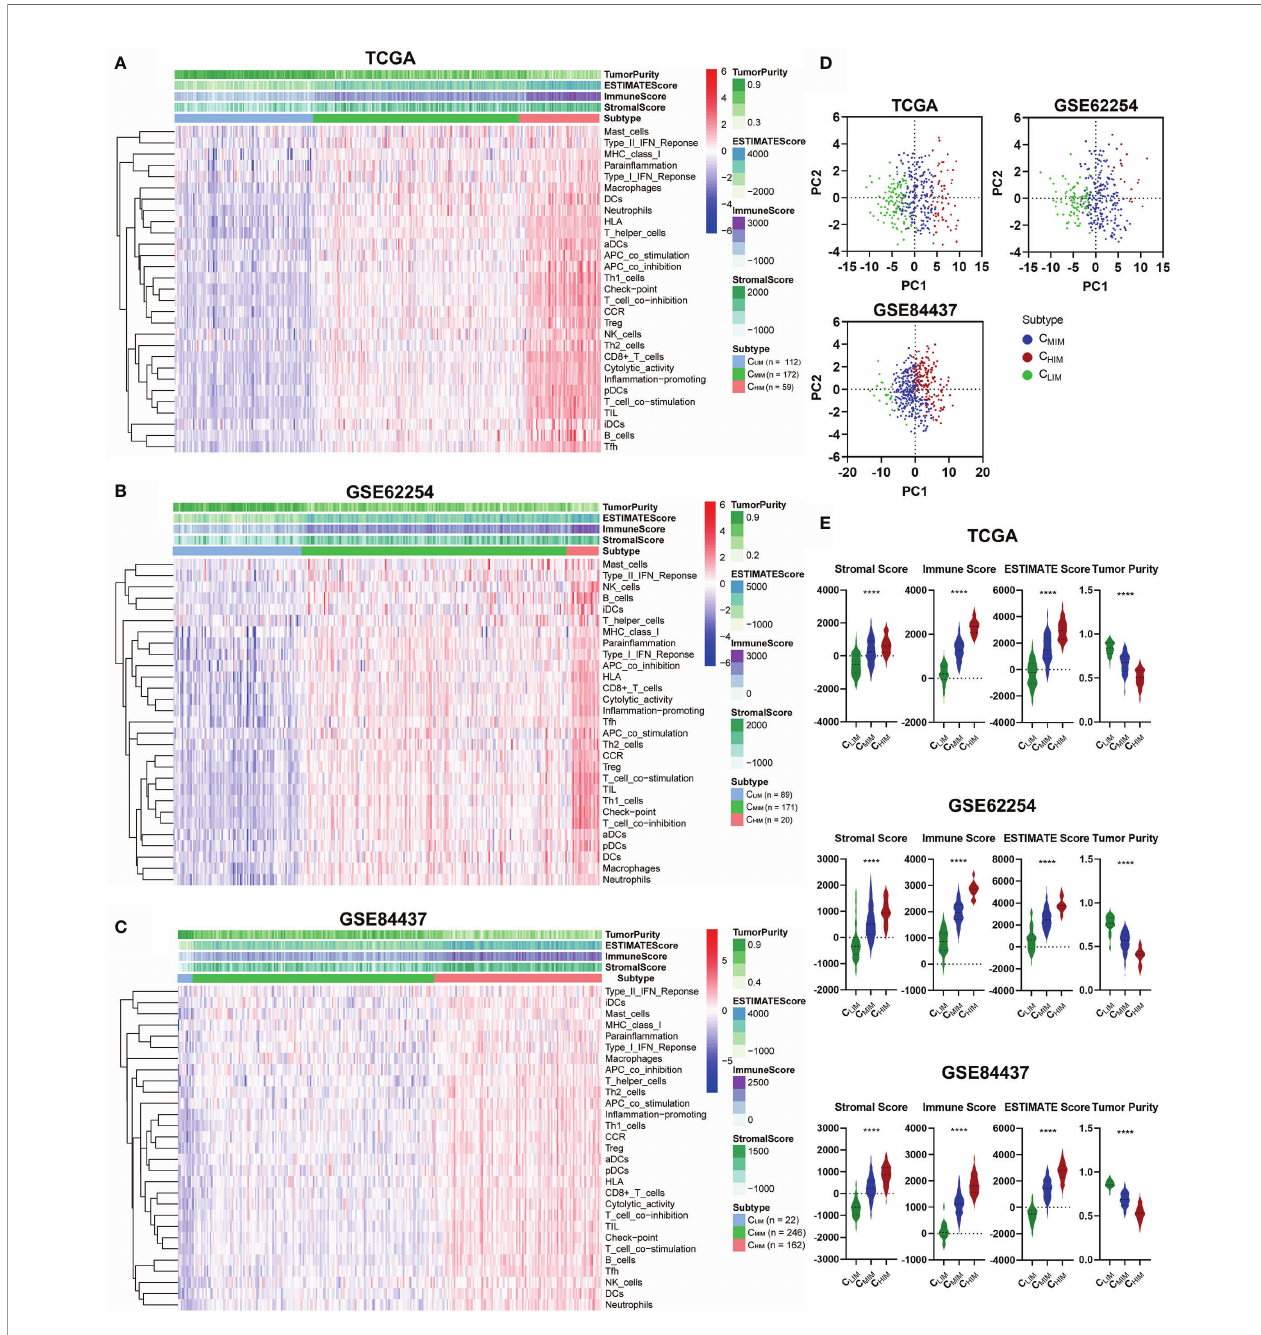
FIGURE 2 | Hierarchical clustering of gastric cancer according to immune signatures. (A – C) Clustering of patients in TCGA (A) , GSE62254 (B) , and GSE84437 (C) datasets into 3 immune-based subtypes. (D) Principal component analysis of immune signature scores across the three databases. (E) Stromal scores, immune scores, ESTIMATE scores, and tumor purities of the three subgroups across three datasets. ****P <